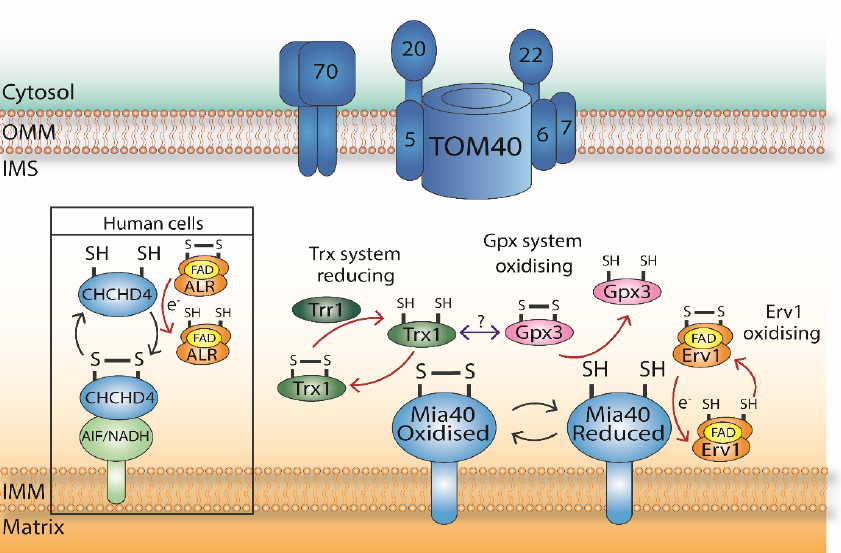
Figure 2. Protein factors modulating Mia40. AIF (Apoptosis-Inducing Factor) controls the import of CHCHD4 (Coiled-Coil-Helix-Coiled-Coil-Helix Domain Containing 4) in human cells. Gpx3 has an oxidising effect. Trx1 has a reducing effect as thioredoxins catalyse the protein disulphide exchange of proteins through a conserved active site. The navy double-headed arrow indicates a potential communication between these two systems. Erv1, and its human homologue ALR, have an oxidising effect on Mia40/CHCHD4 and are responsible for re-oxidising the CPC motif of Mia40 as part of the oxidative folding process in the IMS. Cells with mutated/knocked down Erv1 have reduced levels of MIA substrate